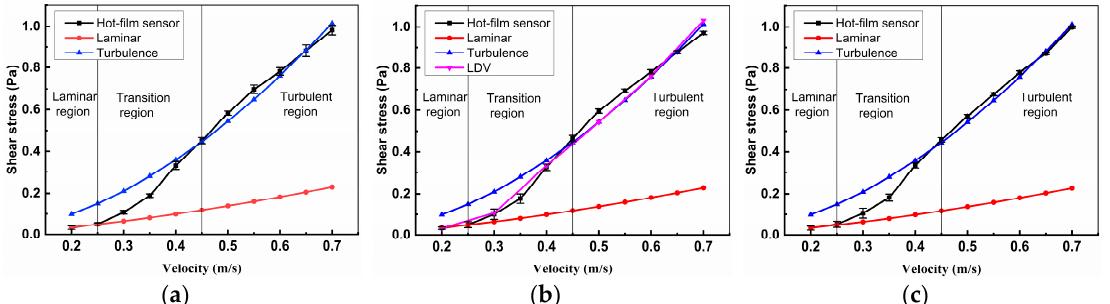
Figure 11. Shear stress measured by the hot-film sensors compared with the empirical formula and velocity profile. ( a ) Sensor 4; ( b ) Sensor 5; and, ( c ) Sensor 7.